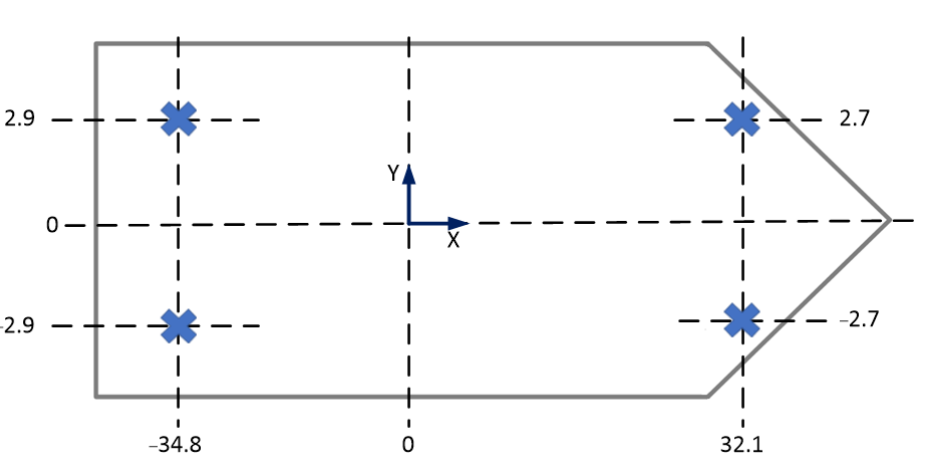
Figure 4. Detailed arrangement of anchor winches on the vessel.